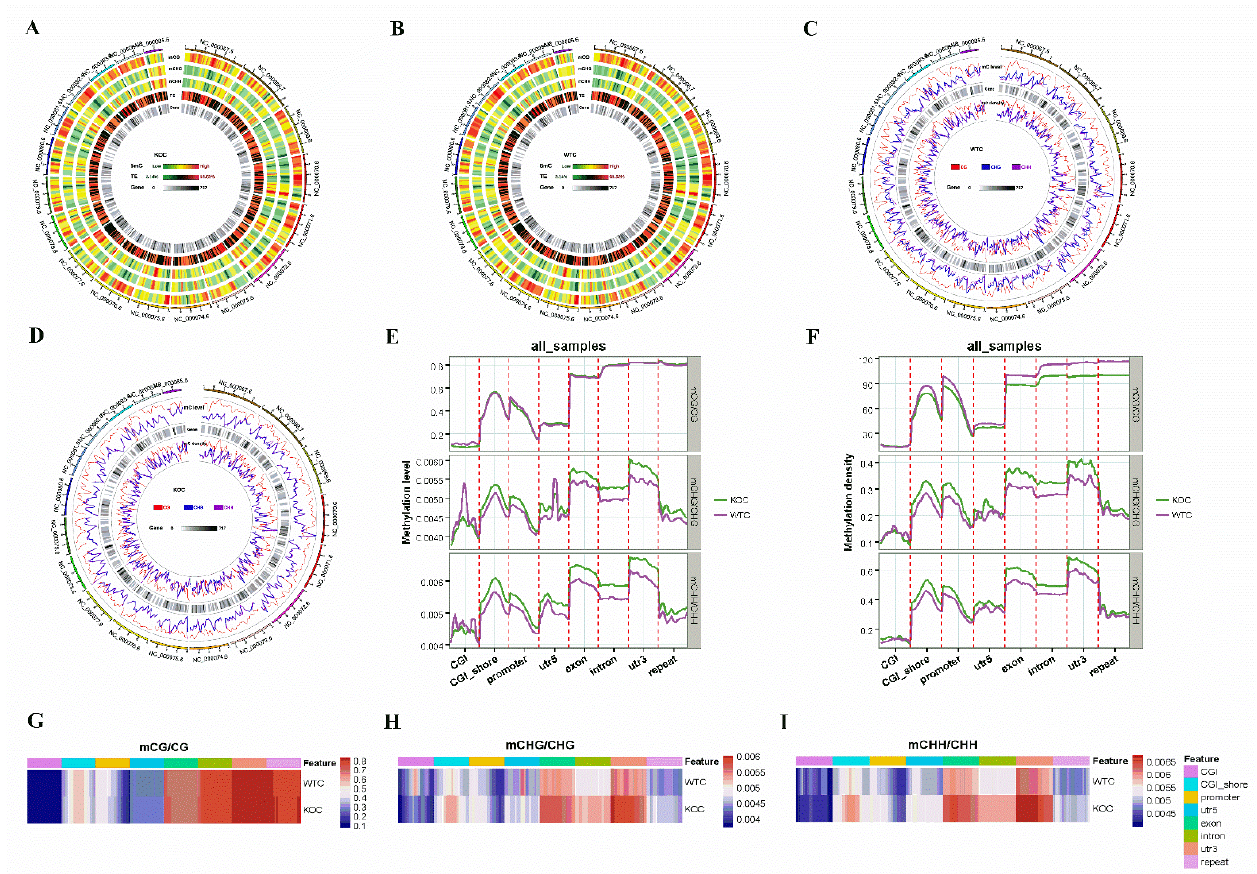
Figure 4. Genome-wide DNA methylation profiling in liver samples. ( A , B ) Density plot of 5-methylcytosine in sequence contexts (mCG, mCHG, mCHH where mC signifies 5-methylcytosine; H = A, C or T), transposable elements and genes. ( C , D ) The distribution of gene density and DNA methylation level across chromosomes. ( E , F ) The methylation level ( E ) and density ( F ) of cytosine in different contexts (CG, CHG, CHH) in featured regions of the genome. ( G – I ) The heat map of the methylation levels of mCG ( G ), mCHG ( H ), and mCHH ( I ) in the gene functional regions.